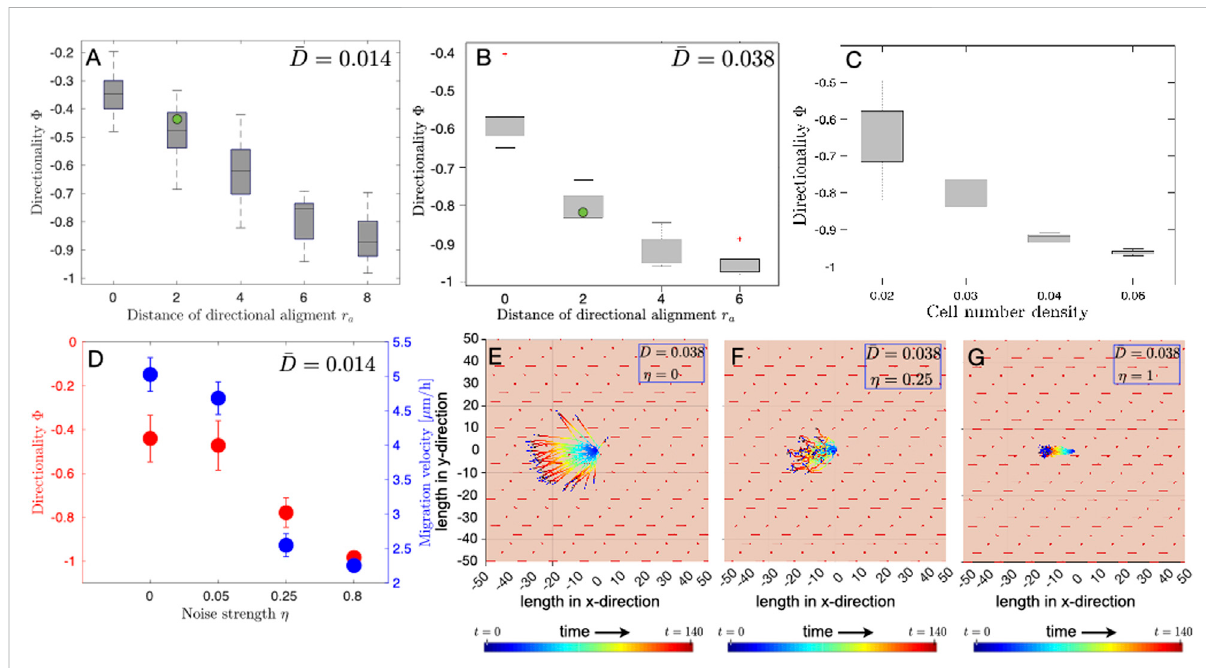
FIGURE 4 In fl uence of the radius of alignment, noise strength and cell number density on the directionality of cell migration. A parameter sweep was performed to study the in fl uence of the radius of directional alignment r a and cell number density on the directionality Φ of electrotactic cell migration of osteoblasts. The green dot in (A) , (B) is the value of directionality obtained from experiments. Whiskers, in the box and whisker plot (A – C) ,denote25 – 75percentilesofdatadistribution. (A) Boxandwhiskerplotofmedians(horizontallines)inthecaseofelectricalstimulationof strength (cid:2) D (cid:1) 0 . 014, which corresponds to 160 V/m in experiments. The values of all the other parameters are as mentioned in Table 1. Cells show higher directedness Φ in their migration towards the anode with increasing distance r a over which directional alignment occurs. Φ = − 1 corresponds to fully directed movement towards the anode, which is located at 180 ° in Figures 1D – I. (B) Box and whisker plot of medians (horizontal lines) in the case ofelectrical stimulation ofstrength (cid:2) D (cid:1) 0 . 038, whichcorrespondsto 436 V/m in theexperiments. The values of all other parameters,except (cid:2) D , are as mentioned in Table 1. (C) Box and whisker plot of medians (horizontal lines), obtained from simulations, in the case of electrical stimulation of strength (cid:2) D (cid:1) 0 . 038 (436 V/m), showing the in fl uence of cell number density on the directionality of cell migration Φ . The values of all other parameters, except (cid:2) D , are as mentioned in Table 1. (D) Directionality order parameter Φ (red) and migration velocity (blue) vs. noise strength η . The values of all other parameters, except η , are as mentioned in Table 1. Error bars show the standard deviation in the directionality and the migration velocity for different values of noise strength obtained from simulations. (E – G) Final positions and trajectories of individual cells in the case of DC electrical stimulation of strength 0.038 (0.038 corresponds to 436 V/m in experiments). Cell positions are adjusted such that all the trajectories originate from x = 0 and y = 0 at t =